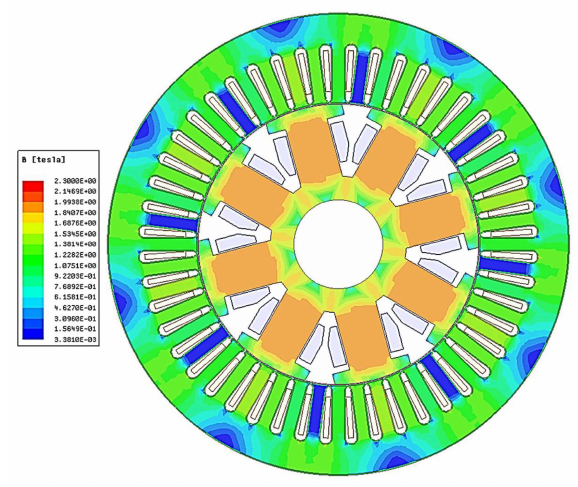
Figure 3. No load flux density plot of basic model at rated speed.